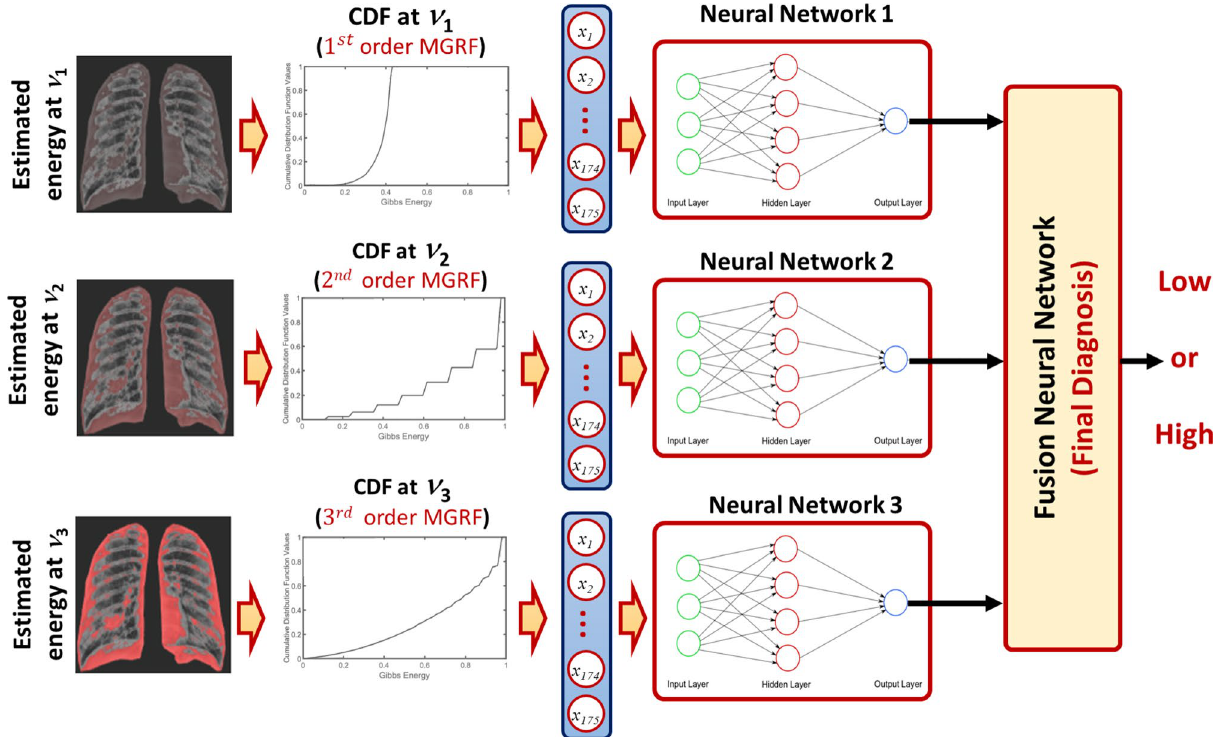
Figure 4. The proposed NN-based fusion diagnostic